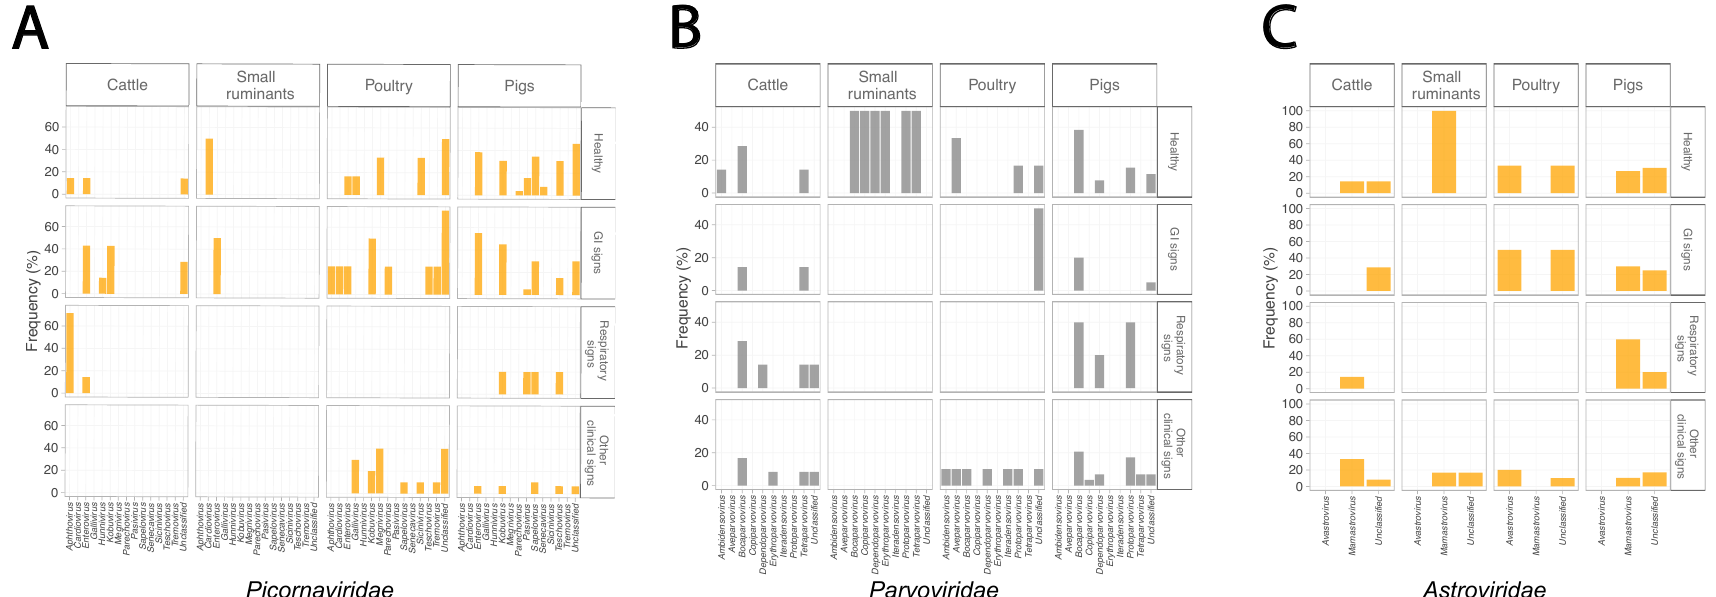
Figure 6. Frequencies of virus genera of top three most abundant virus families stratified by health conditions. ( A ) Picornaviridae . ( B ) Parvoviridae . ( C ) Astroviridae . Color code is based on host range and adapted from Figure